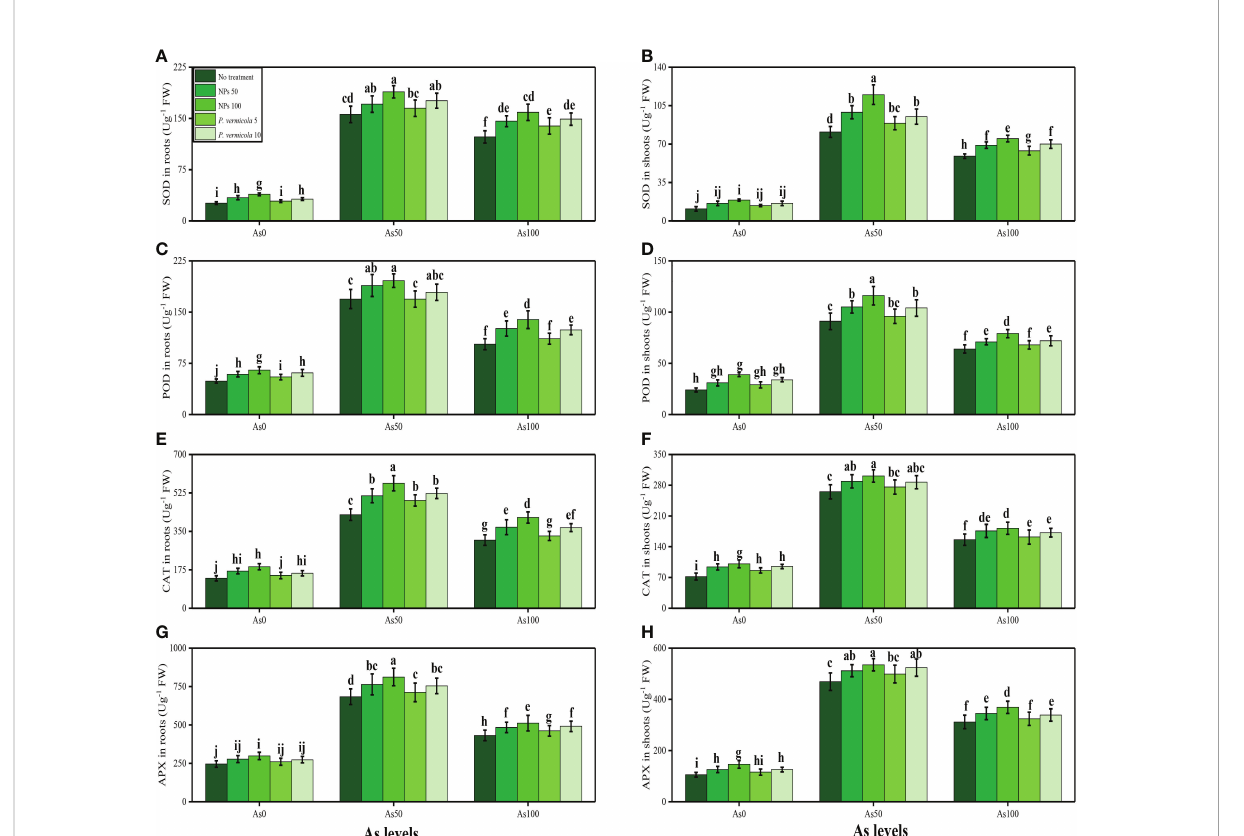
FIGURE 4 Effect of combined application of various levels of iron oxide nanoparticle (FeO-NPs) (i.e., 50 mg/l − 1 and 100 mg/l − 1 ) and plant growth- promoting bacteria ( Providencia vermicola ) (i.e., 5 ppm and 10 ppm) on superoxide dismutase (SOD) activity in the roots (A) , SOD activity in the shoots (B) , peroxidase (POD) activity in the roots (C) , POD activity in the shoots (D) catalase (CAT) activity in the roots (E) , CAT activity in the shoots (F) , ascorbate peroxidase (APX) activity in the roots, (G) and APX activity in the shoots (H) of Ajwain ( Trachyspermum ammi seedlings) grown under various stress levels of arsenic (i.e., 0 m M, 50 m M, and 100 m M). Values are demonstrated as means of four replicates along with standard deviation (SD; n = 4). Two-way ANOVA was performed and means differences were tested by Tukey ’ s highly signi fi cant difference post-hoc test ( p < 0.05). Different lowercase letters on the error bars indicate signi fi cant difference between the